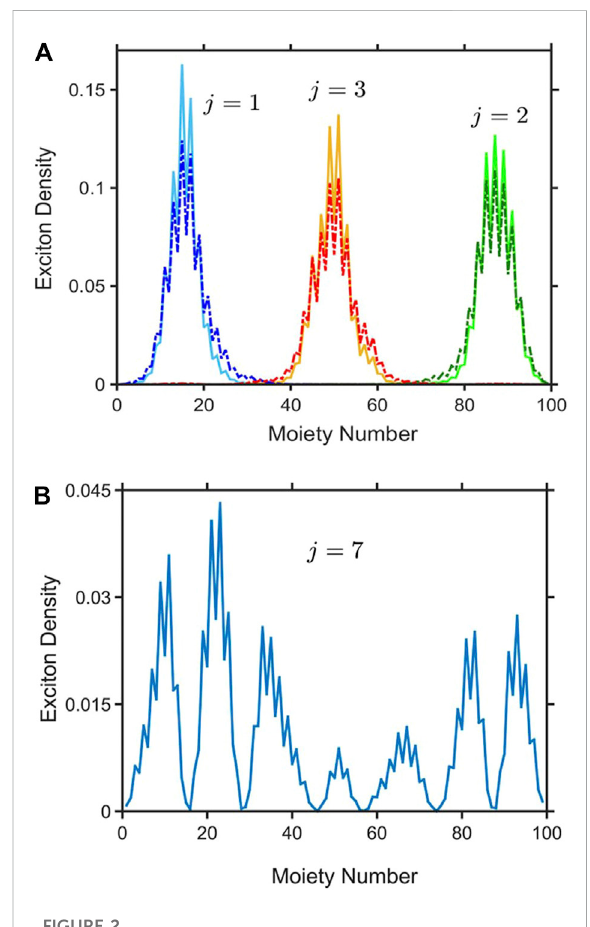
FIGURE 2 (A) The density of three local exciton ground states (LEGSs, dotted curves) and the three vibrationally relaxed states (VRSs, solid curves) for one particular static conformation of a PPV polymer chain made up of 50 monomers. The exciton center-of-mass quantum number, j , for each state is also shown. (B) The exciton density of a quasiextended exciton state (QEES), with quantum number j = 7. Reproduced from J. Chem. Phys. 148, 034901 (2018) with the permission of AIP